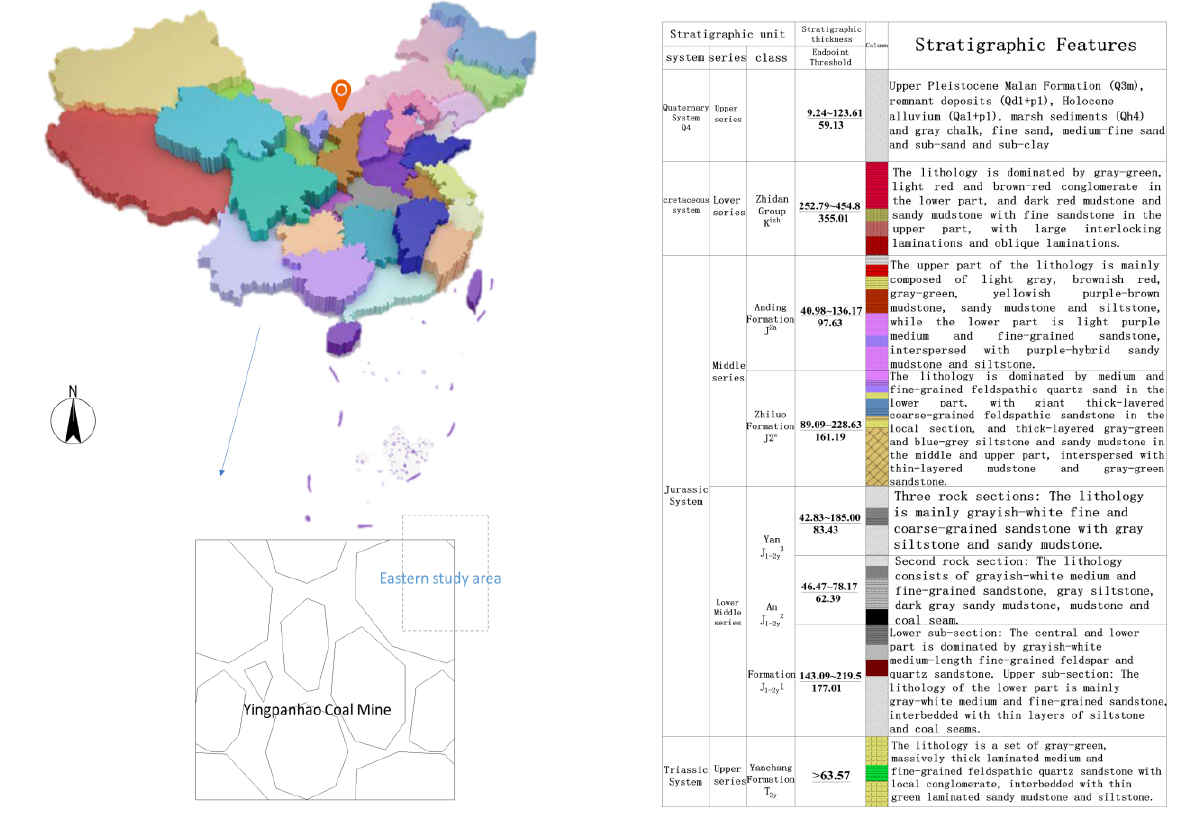
Figure 3. Location of the Yingpanhao Coal Mine and column diagram of boreholes.